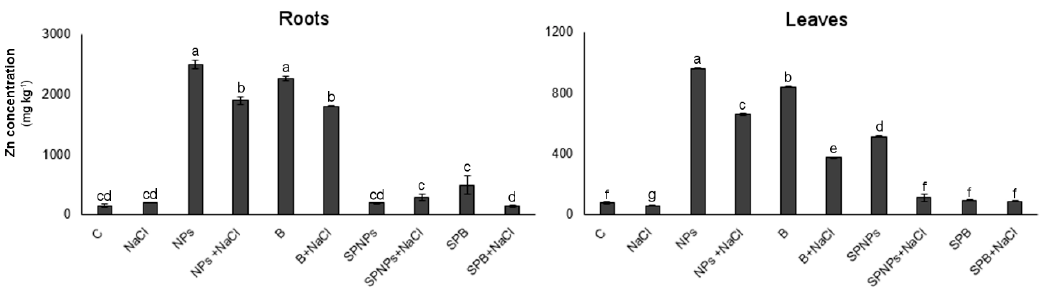
Figure 2. Zinc concentration in roots and leaves of T. turgidum L. ssp. durum cv. Cappelli without priming and salt treatment (C), with salt treatment without priming (NaCl), with ZnO priming in the root zone without salt treatment (nanoparticles, NPs or bulk form, B), with ZnO priming in the root zone with salt treatment (nanoparticles, NPs + NaCl or bulk form, B + NaCl), with ZnO priming as a leaf spray without salt treatment (nanoparticles, SPNPs or bulk form, SPB), and with ZnO priming as a leaf spray with salt treatment (nanoparticles, SPNPs + NaCl or bulk form, SPB + NaCl): values are means of at least three replicates ± SE. When ANOVA highlighted significant differences, Tukey’s post hoc test was performed, and different letters indicate significantly different mean values at p < 0.05.